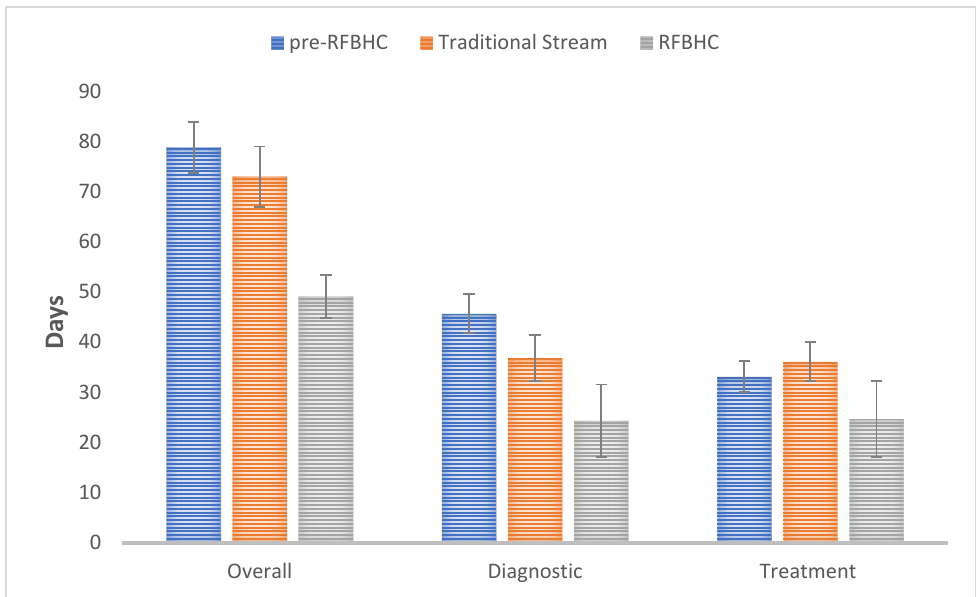
Figure 3. Primary mean wait time endpoints: Overall (presentation — initial treatment), Diagnostic (presentation-pathology), and Treatment (pathology — initial treatment). Whiskers represent 95% Confidence Intervals.